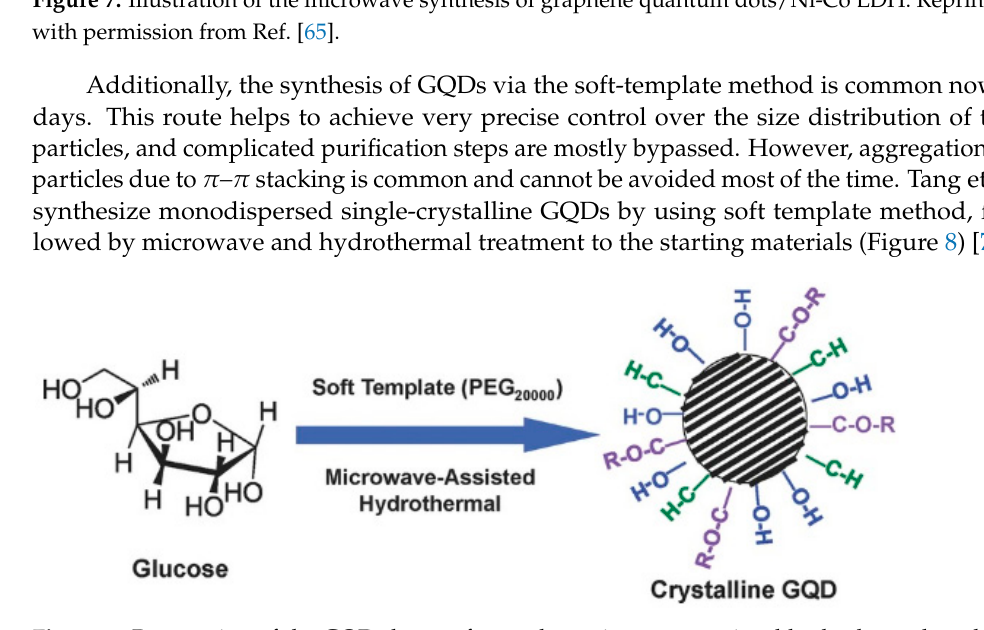
Figure 8. Preparation of the GQDs by a soft-template microwave-assisted hydrothermal method. Reprinted with permission from Ref. [77].